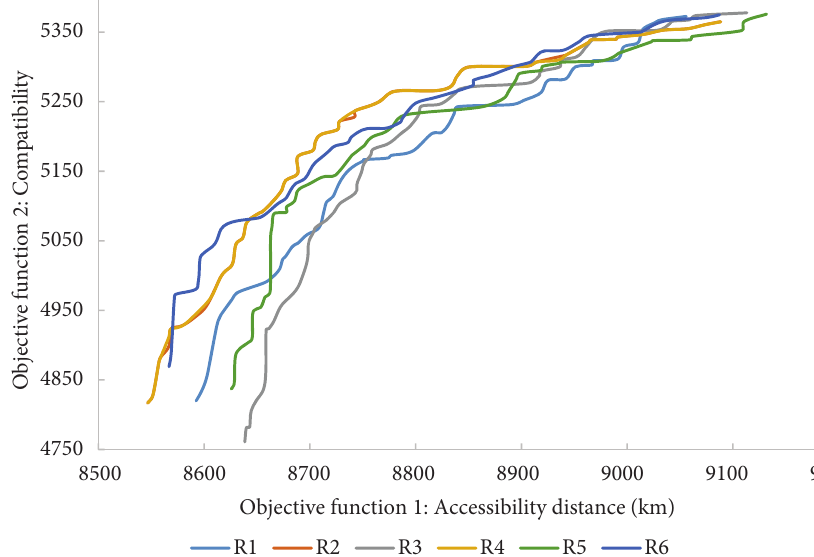
Figure 6. Pareto fronts for repeatability investigation (1000